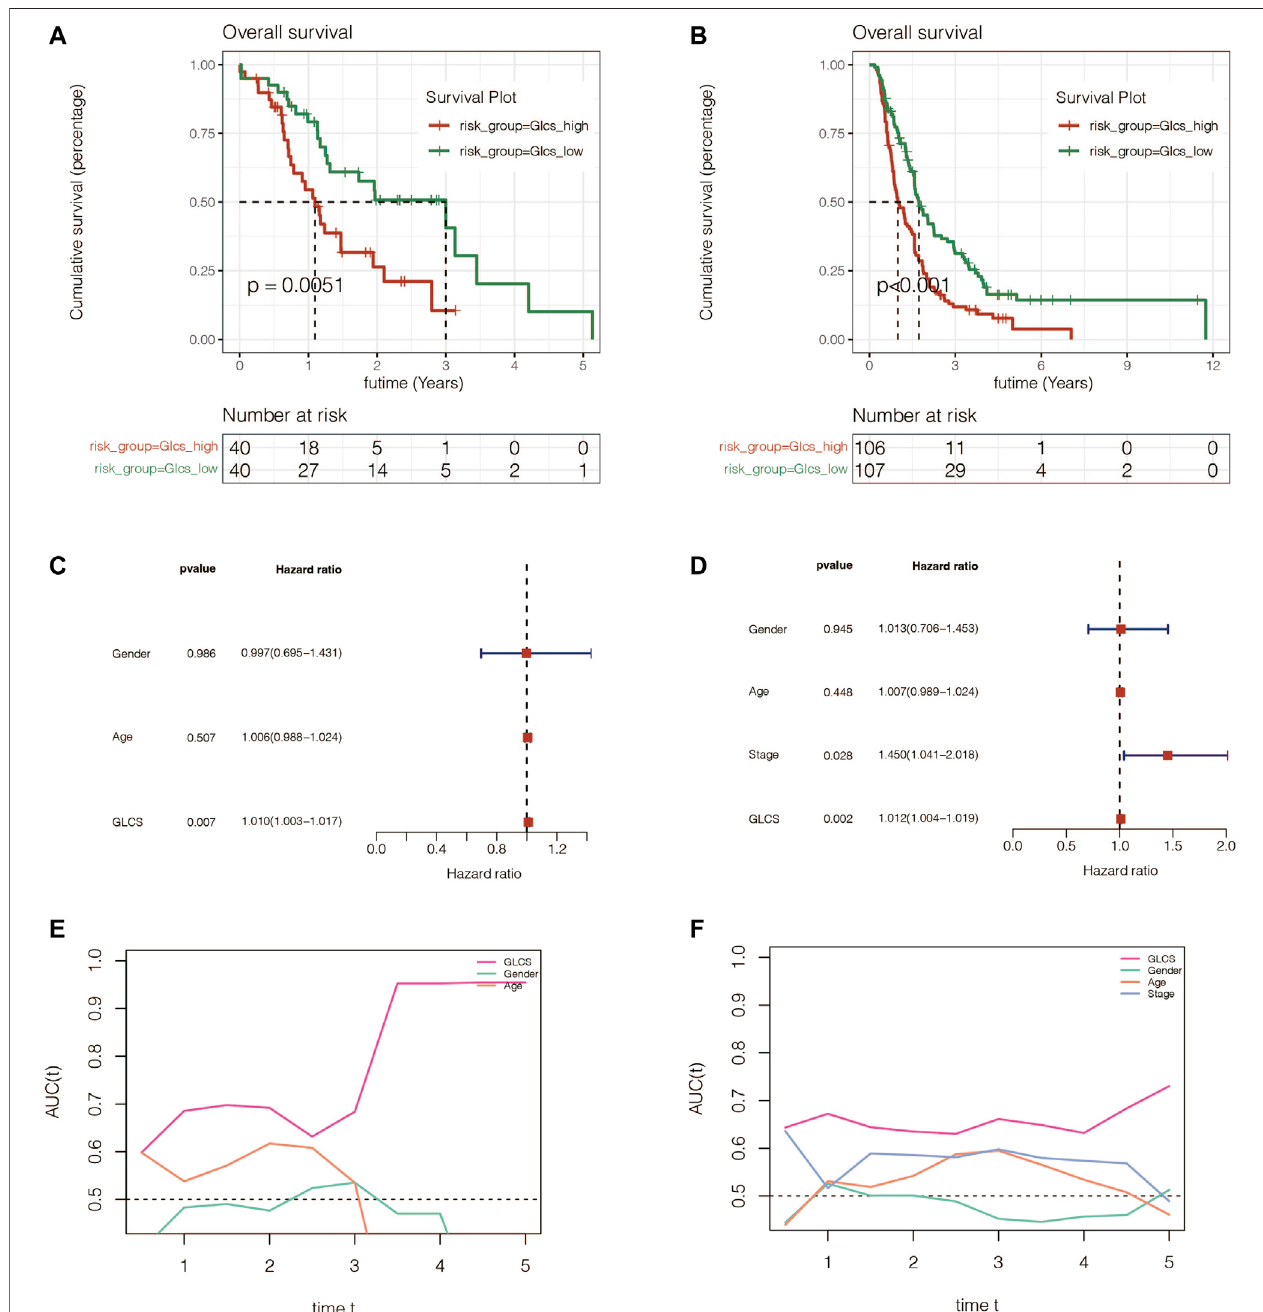
FIGURE 4 | Assessment of the gene signature in extra validation cohorts. (A) Survival analysis in the PACA-AU cohort suggested that the prognosis of the GLCS- high group was worse ( p = 0.0051). (B) Survival analysis in the PACA-CA cohort suggested that the prognosis of the GLCS-high group was worse ( p < 0.001). (C,D) Multivariate Cox analysis in the PACA-AU cohort and PACA-CA cohort revealed that GLCS was an independent prognostic factor. (E,F) AUC of GLCS and clinical features in the PACA-AU cohort and PACA-CA cohort.